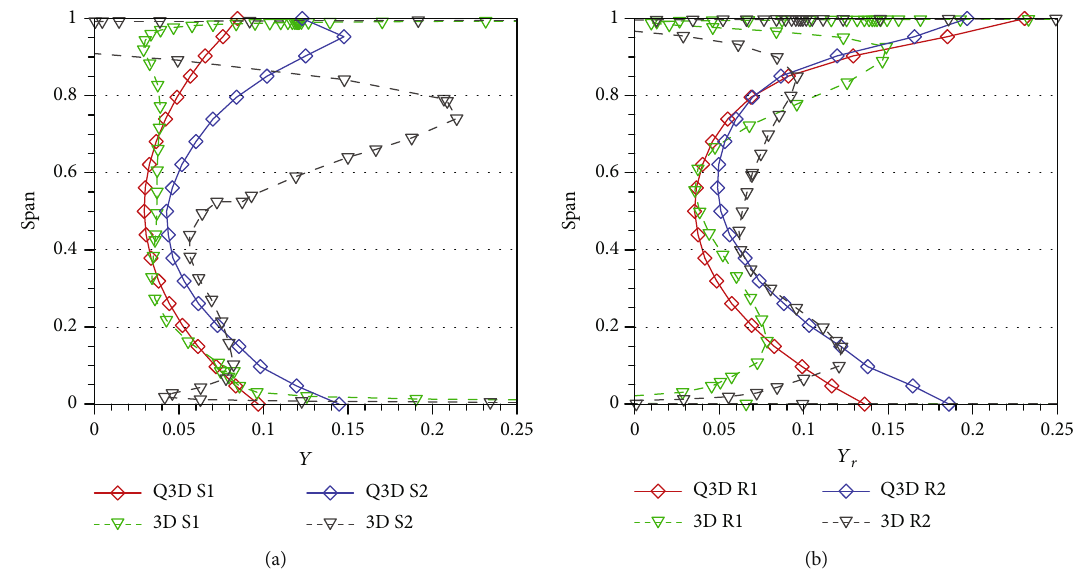
Figure 14: Total pressure loss of the two-stage turbine: (a) stator total pressure loss; (b) rotor relative total pressure loss.